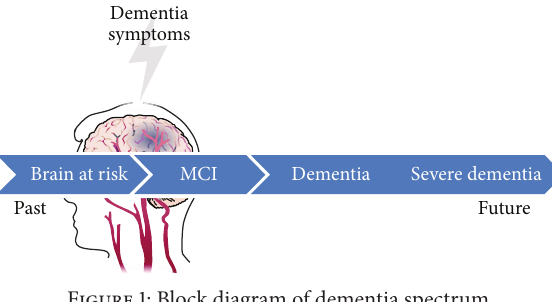
Figure 1: Block diagram of dementia